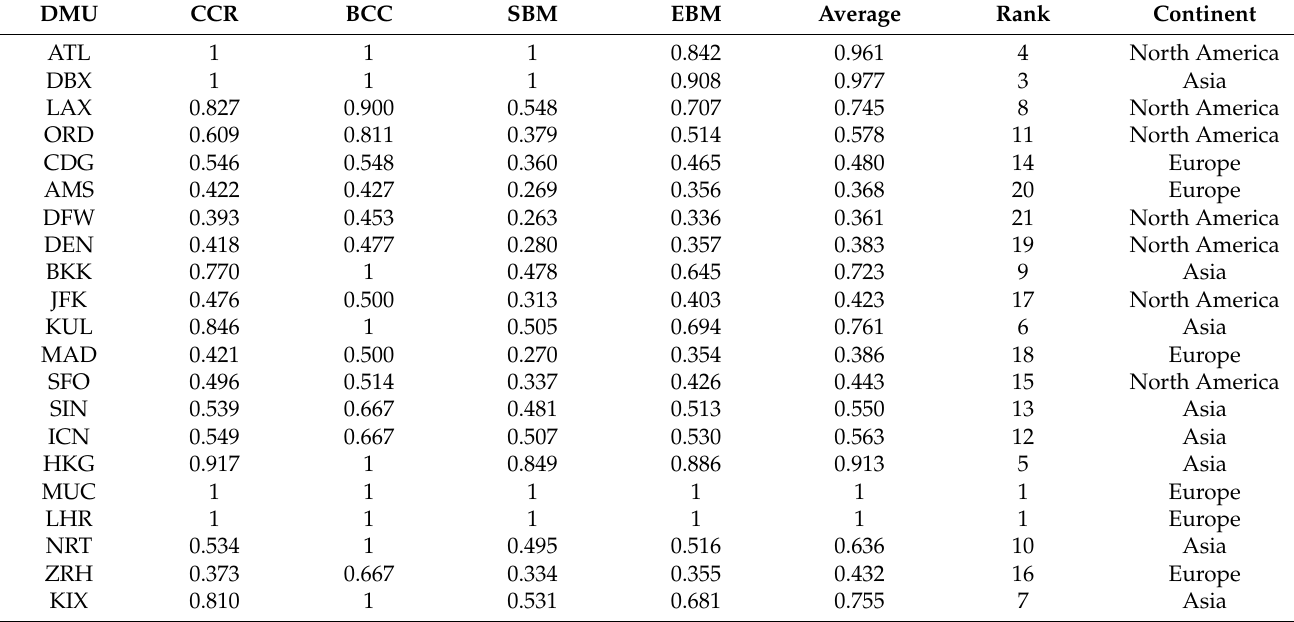
Table 8. The average efficiency score of DEA